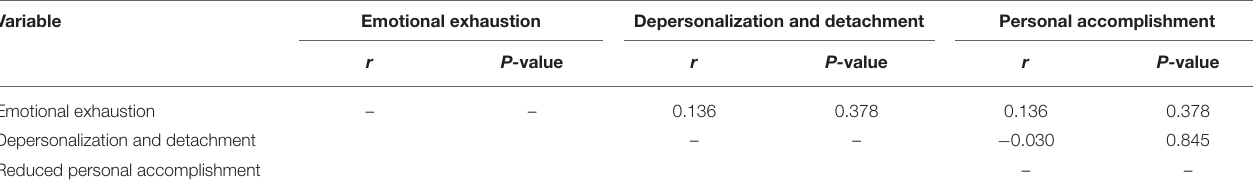
TABLE 4 | Pearson correlation between emotional exhaustion, depersonalization and detachment and reduced personal accomplishment among palliative care clinicians in Saudi